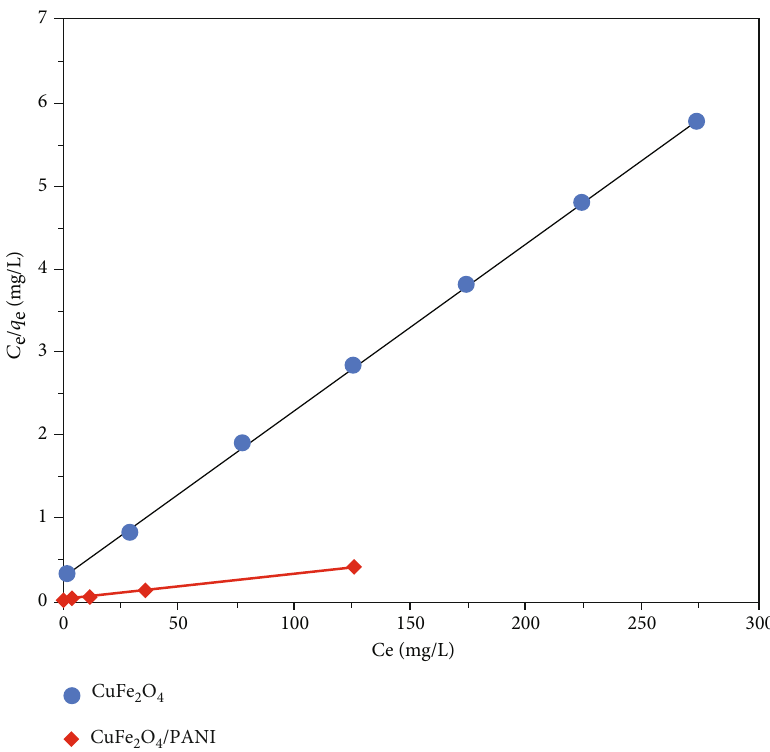
Figure 12: Fitting curves of Langmuir isotherm adsorption model for uranium on CuFe